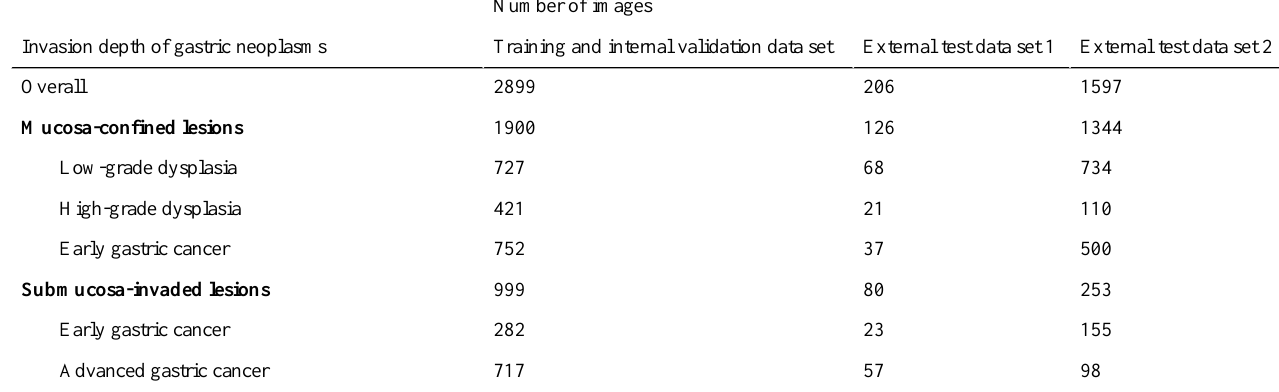
Table 1. Summary of images in each data